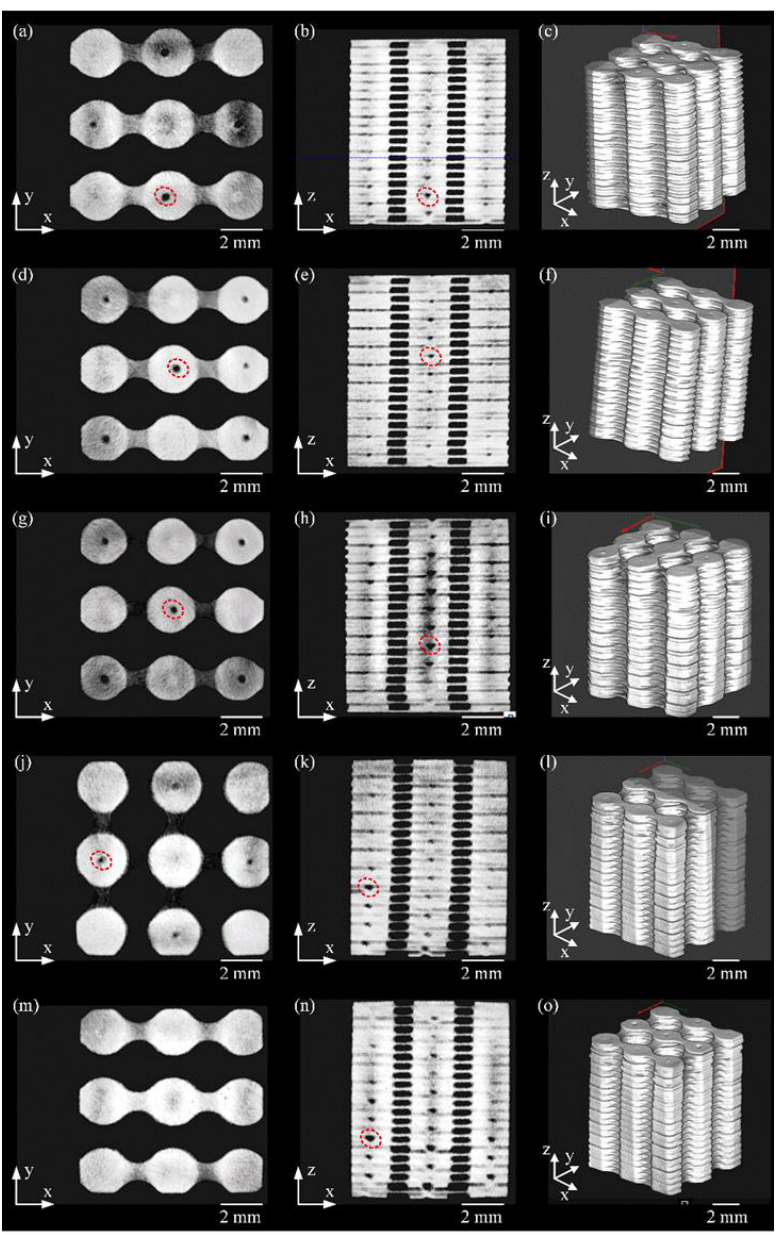
Figure 6. Pictures of the micro-CT analysis. Samples 1 – 5 ( a , d , g , j , m ) top, ( b , e , h , k , n ) lateral, and ( c , f , i , l , o ) isometric views.